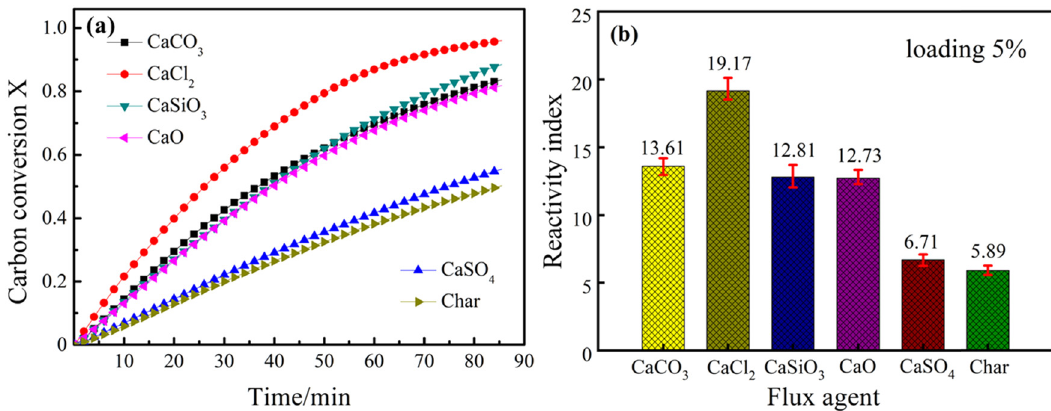
Figure 4: E ff ect of Ca - based fl ux agents on the reactivity of ZJX char: ( a ) gasi fi cation rate and ( b ) gasi fi cation reactivity